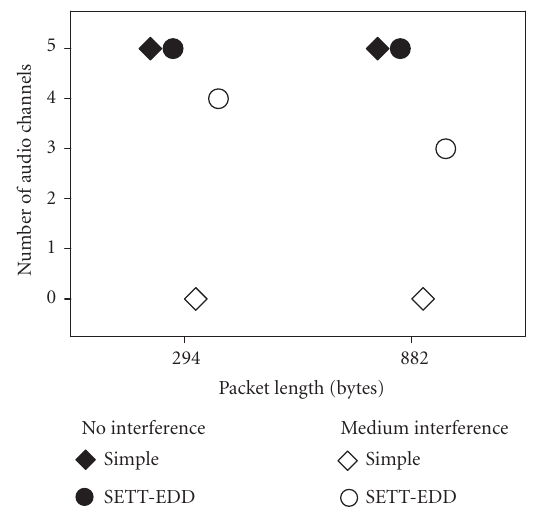
Figure 14: Number of serviced audio channels versus packet length for error-free digital WLAN